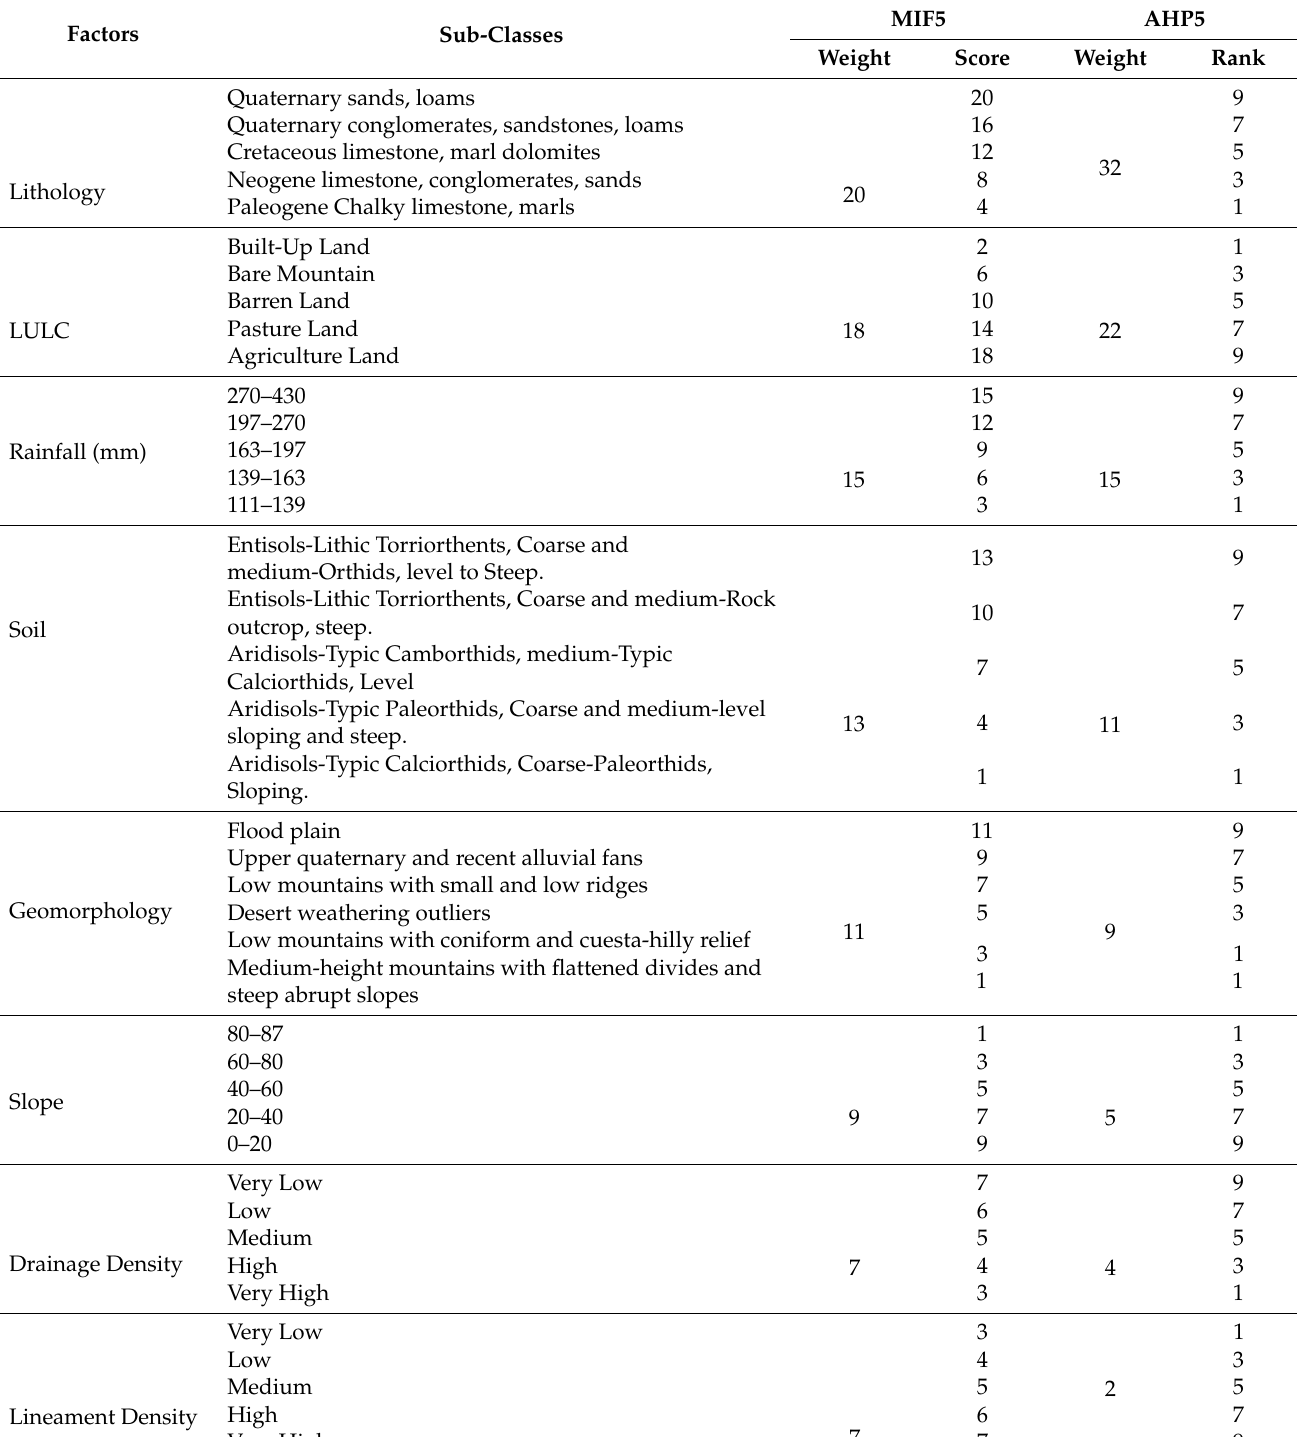
Table A5. Weight and scores of specific characteristics in (MIF5 and AHP5) are assigned to factors that influence